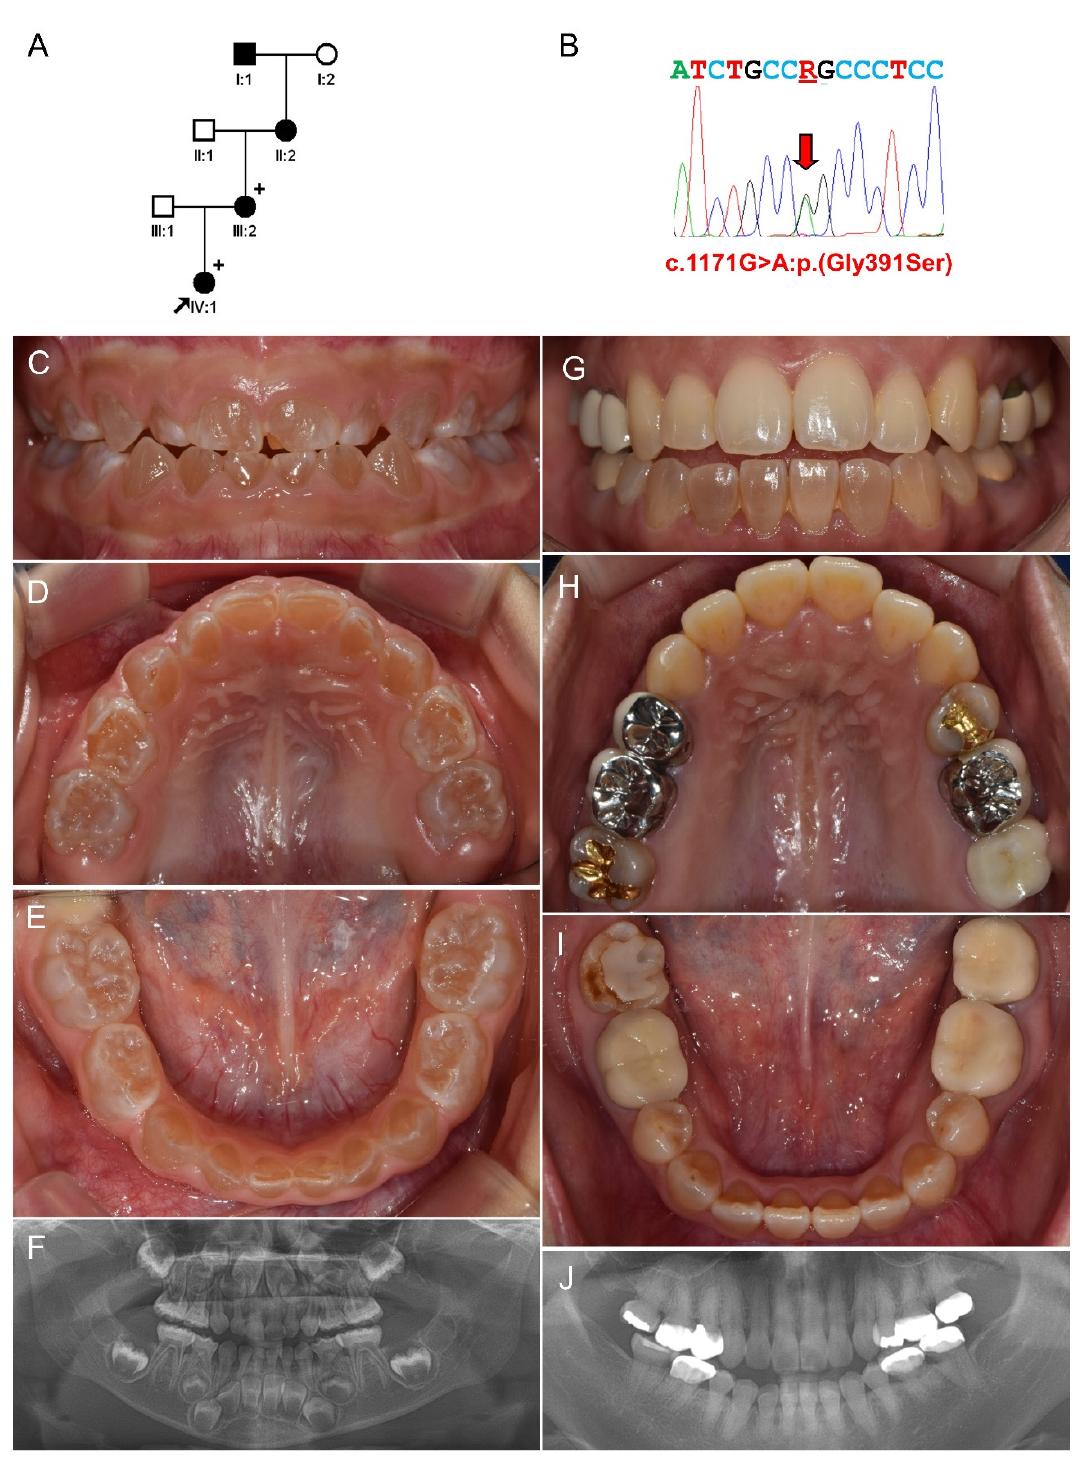
Figure 2. Pedigree, sequencing chromatogram, clinical photos, and panoramic radiograph of Family 2. ( A ) Pedigree of Family 2. The black filled symbol indicates the affected individual, and the proband is indicated by a black arrow. Plus signs above the symbols indicate participating individuals. ( B ) Sequencing chromatogram of the proband’s mother. Nucleotide sequences are shown above the chromatogram. The red arrow indicates the location of the mutation (NM_000089.4:c.1171G>A) (R: A or G). ( C – E ) Clinical photos of the proband at age 3 years and 10 months. ( F ) Panoramic radiograph of the proband at age 3 years and 10 months. ( G – I ) Clinical photos of the proband’s mother at age 32 years. Mild brown opalescent discoloration can be seen in the mandibular anterior teeth, but the maxillary anterior teeth are unremarkable. ( J ) Panoramic radiograph of the proband’s mother at age 32 years.